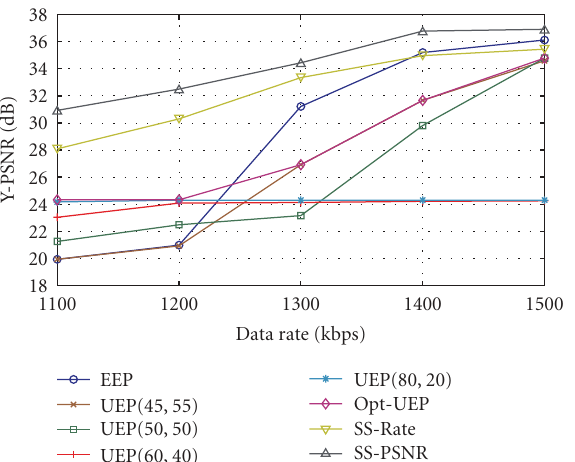
Figure 10: PSNR versus data rate at PLR of 10% for the “Paris” sequence—burst